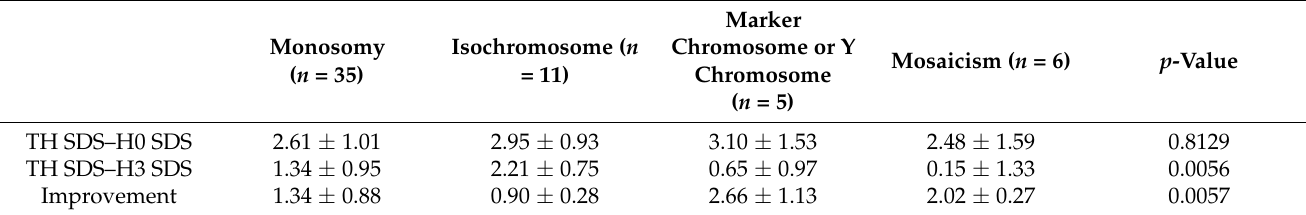
Table 4. Comparison of the growth catch-up in reference to target